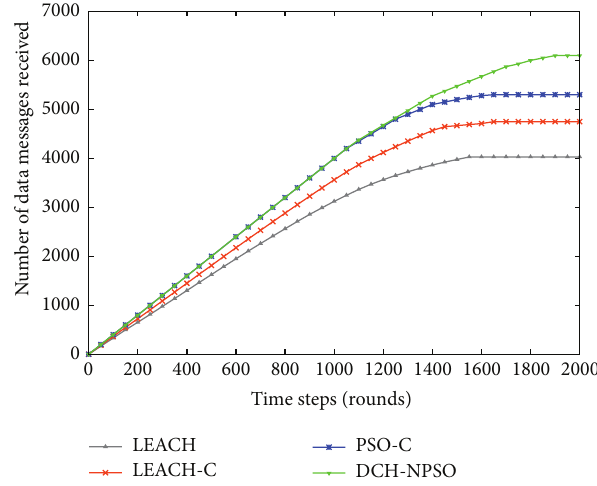
Figure 3: The flowchart of the DCH-NPSO protocol for cluster